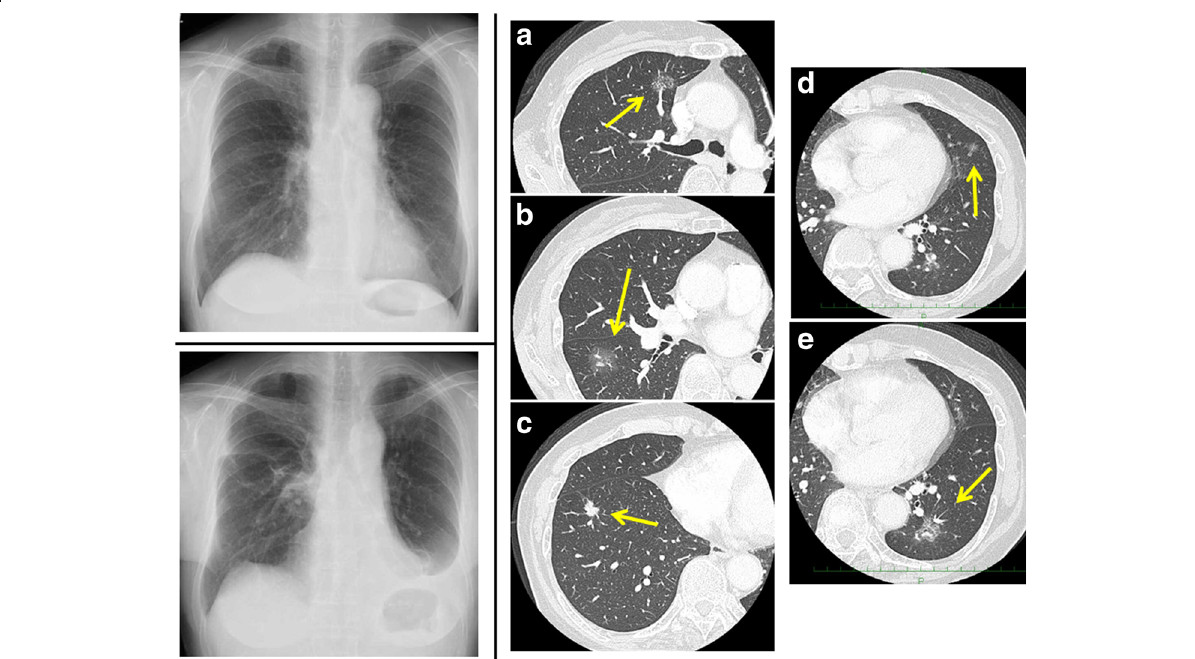
Fig. 1 (Left, upper) Chest roentgenogram at presentation. (Right) Preoperative computed tomography (CT) showing bilateral lung nodules as follows: a part-solid ground-glass nodule (GGN, 23 mm) in the anterior segment (S3) of the right upper lobe, b pure GGN (24 mm) in the superior segment (S6) of the right lower lobe, c solid nodule (13 mm) in the anterior basal segment (S8) of the right lower lobe, d pure GGN (8 mm) in the lingular segment of the left upper lobe, and e part-solid GGN (35 mm) in the left lower lobe. (Left lower) Chest roentgenogram after two-staged bilateral